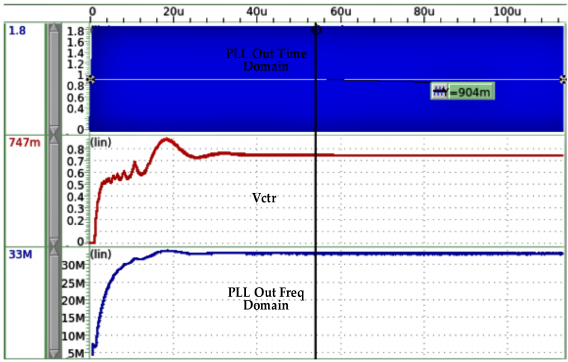
Figure 17. Transient simulation result for whole